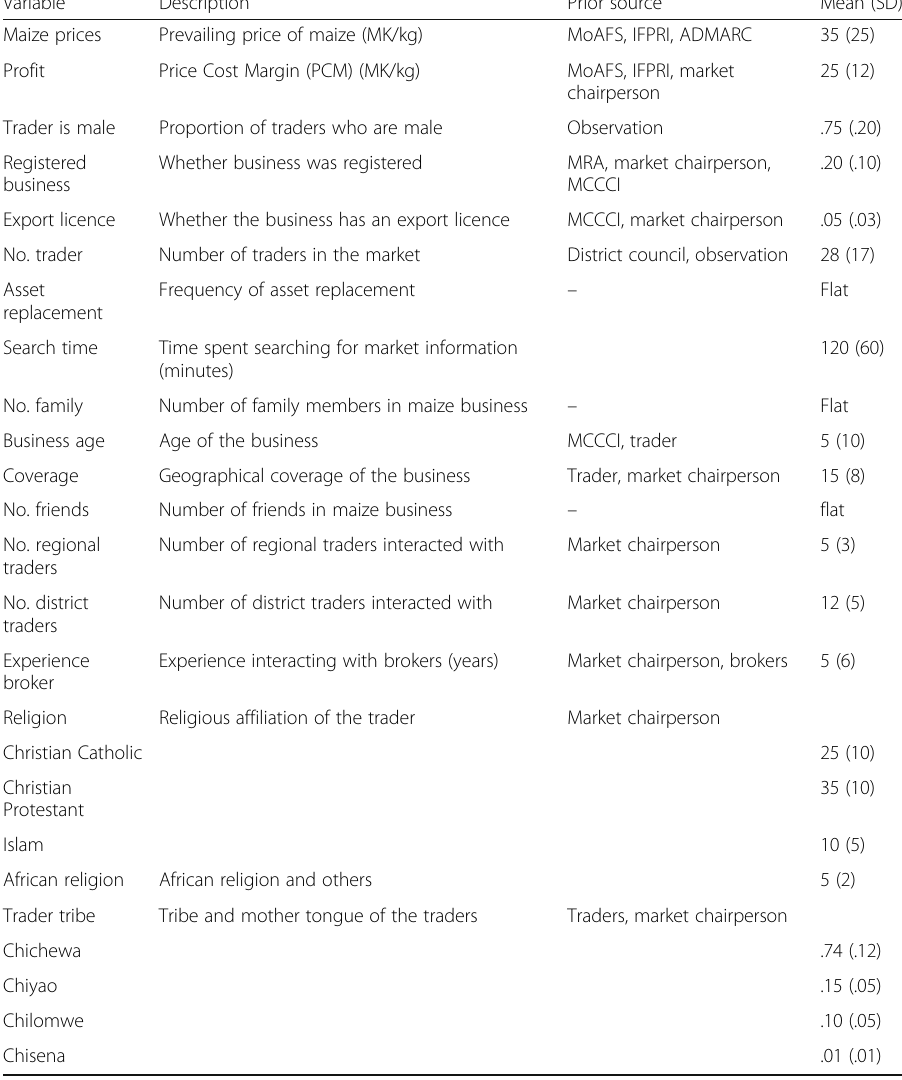
Table 2 Key variables used in the analysis and prior elicited information